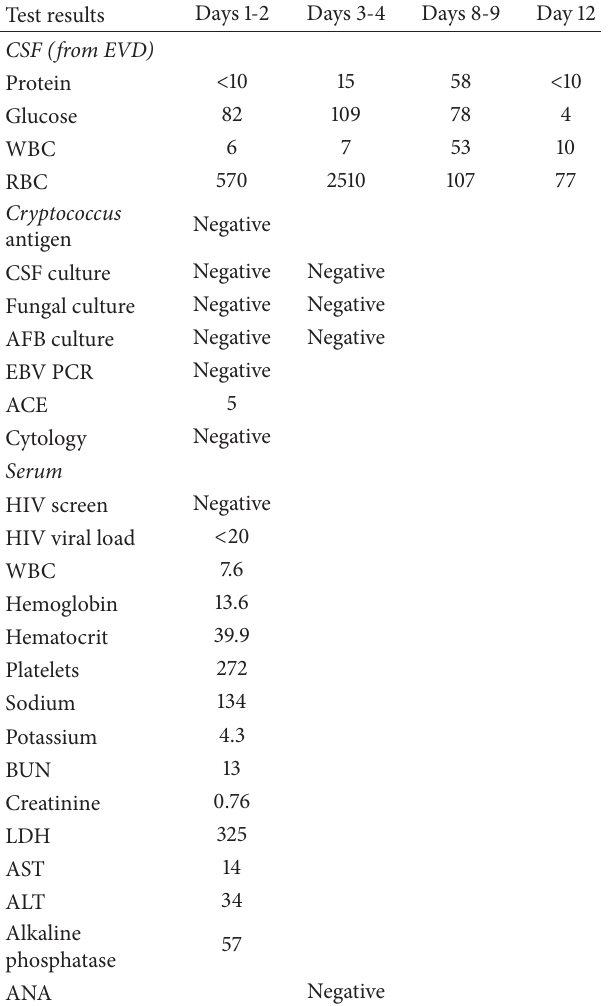
Table 1: Serum and CSF results.